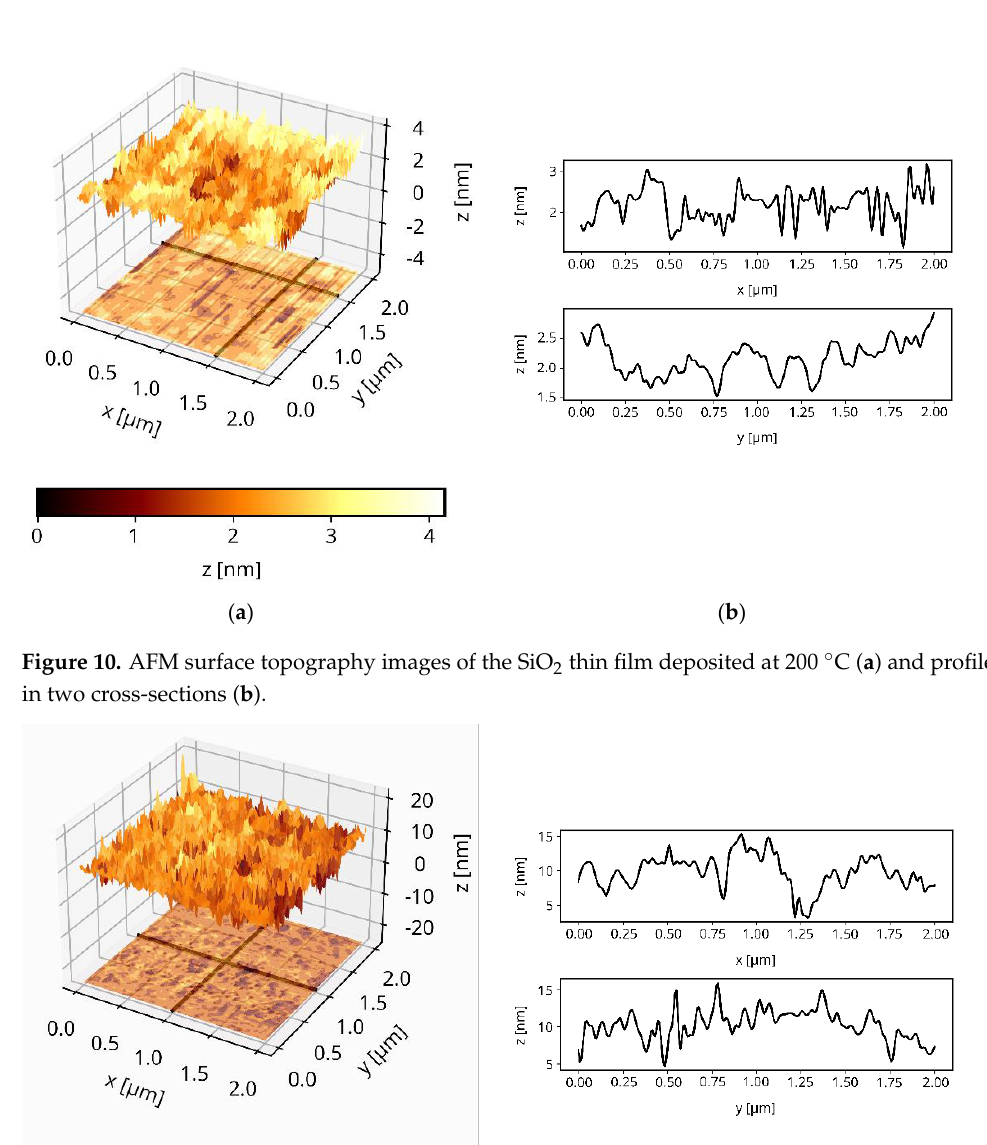
( b ) Figure 9. PQXOH photoluminescence in a solution of MCHX (black line), THF (green line), ACN (blue line), and SiO 2 + PQXOH film (red line) ( a ), and the image of substrates with a layer of SiO 2 , respectively, 2d = 2350 nm ( left ) and SiO 2 + PQXOH, 2d = 2780 nm ( right ), illuminated by a lamp λ = 365 nm ( b ). 3.5. The Surface Morphology